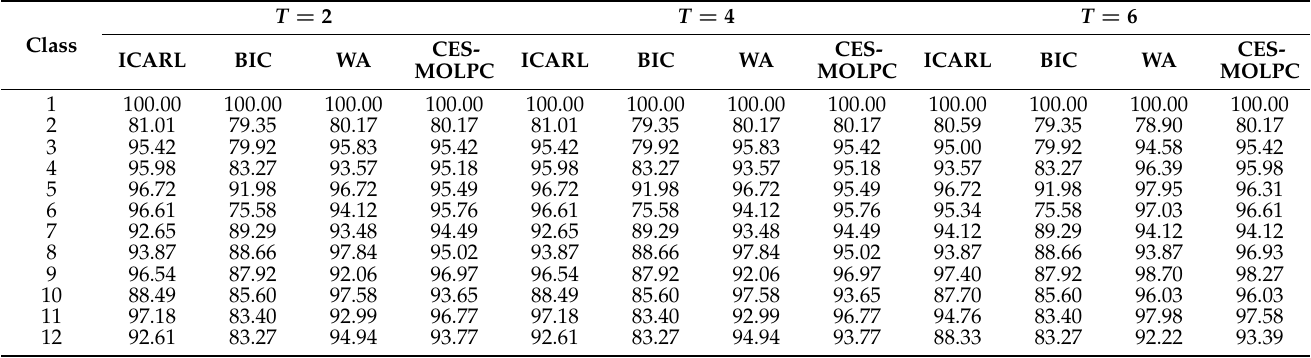
Table 4. Results of experiments on the ACARS data set ( T =